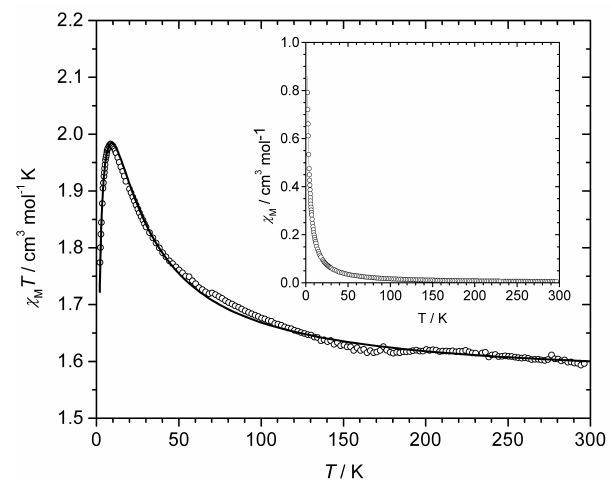
Figure 5. Temperature dependence of the χ M T product for 1 : ( ○ ) experimental; ( __ ) best-fit curve through equation (3) (see text). Inset: χ M versus T plot.